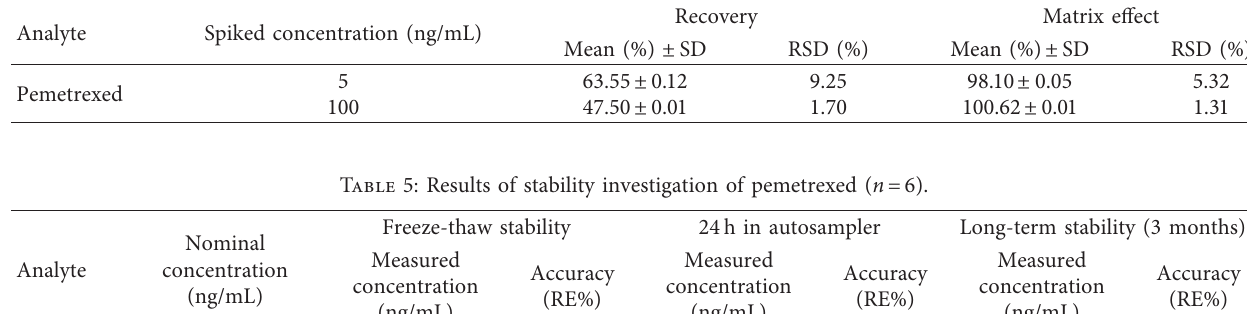
Table 4: The extraction recovery and matrix effect results of pemetrexed.